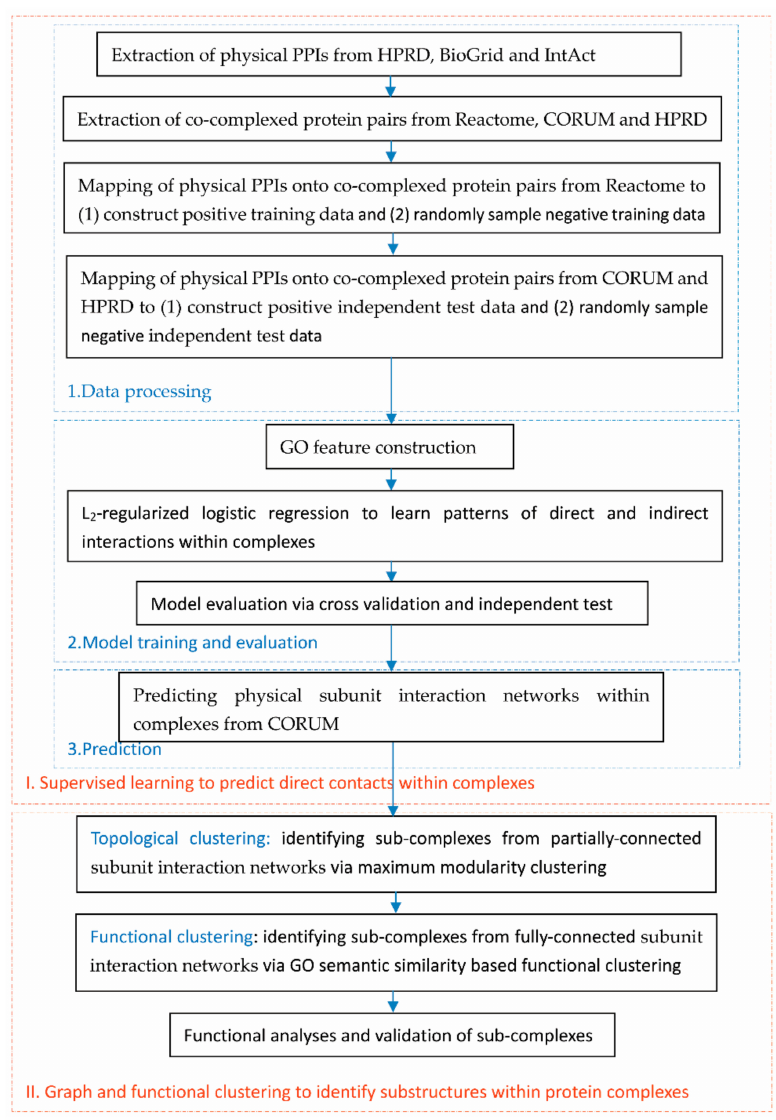
Figure 1. Flowchart of the proposed